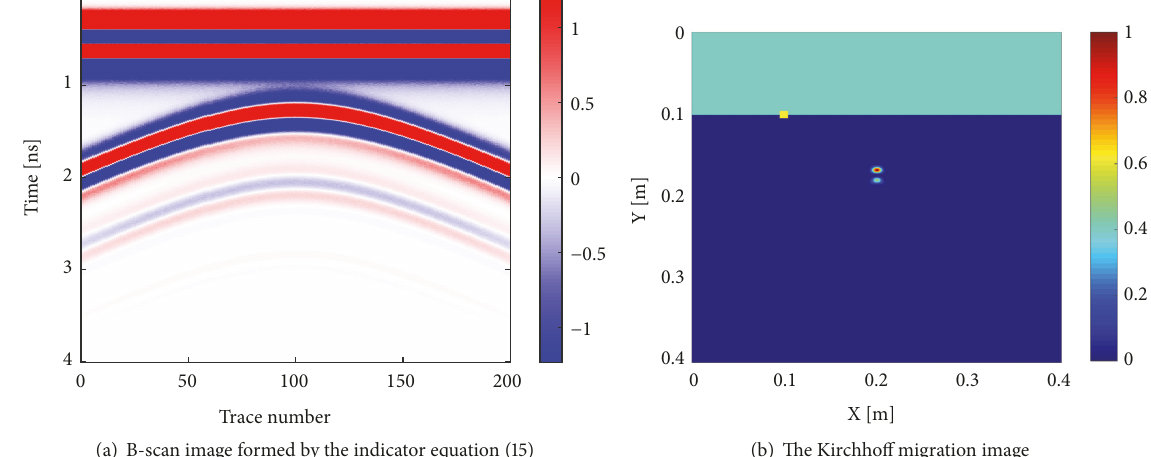
Figure 6: Imaging a small scatterer using polluted synthetic data at the noise level 𝛿 = 100 %.